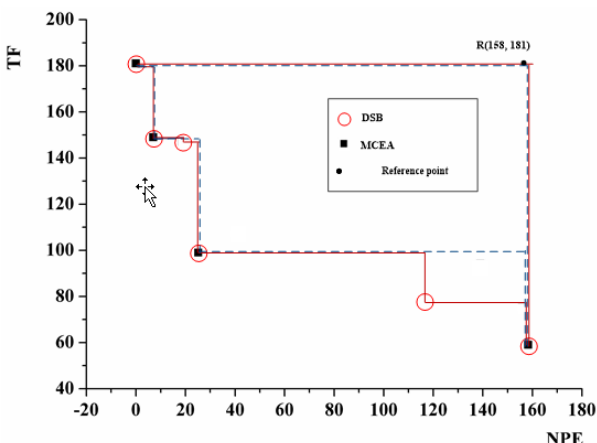
Figure 6. The calculation method schematic diagram of the hypervolume indicator.